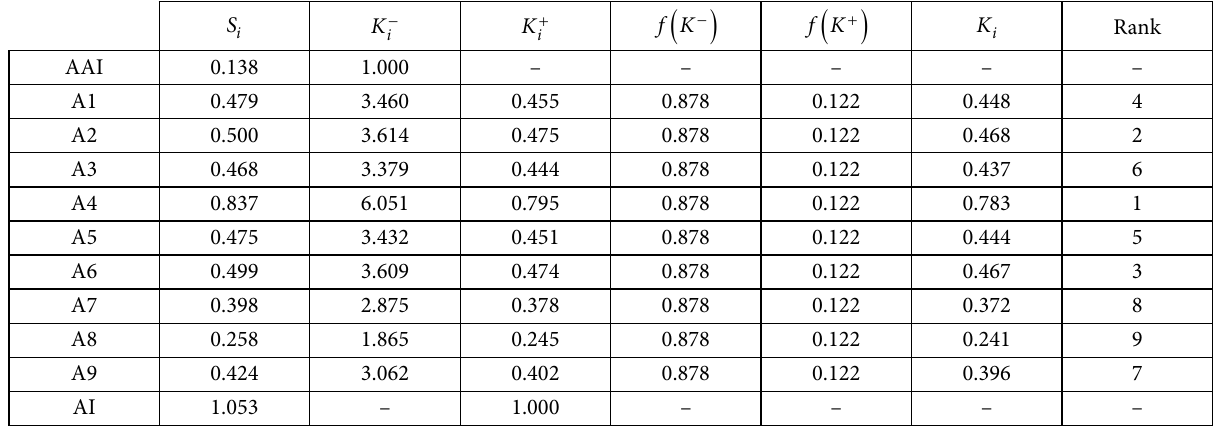
Table 3. Final results obtained by proposed